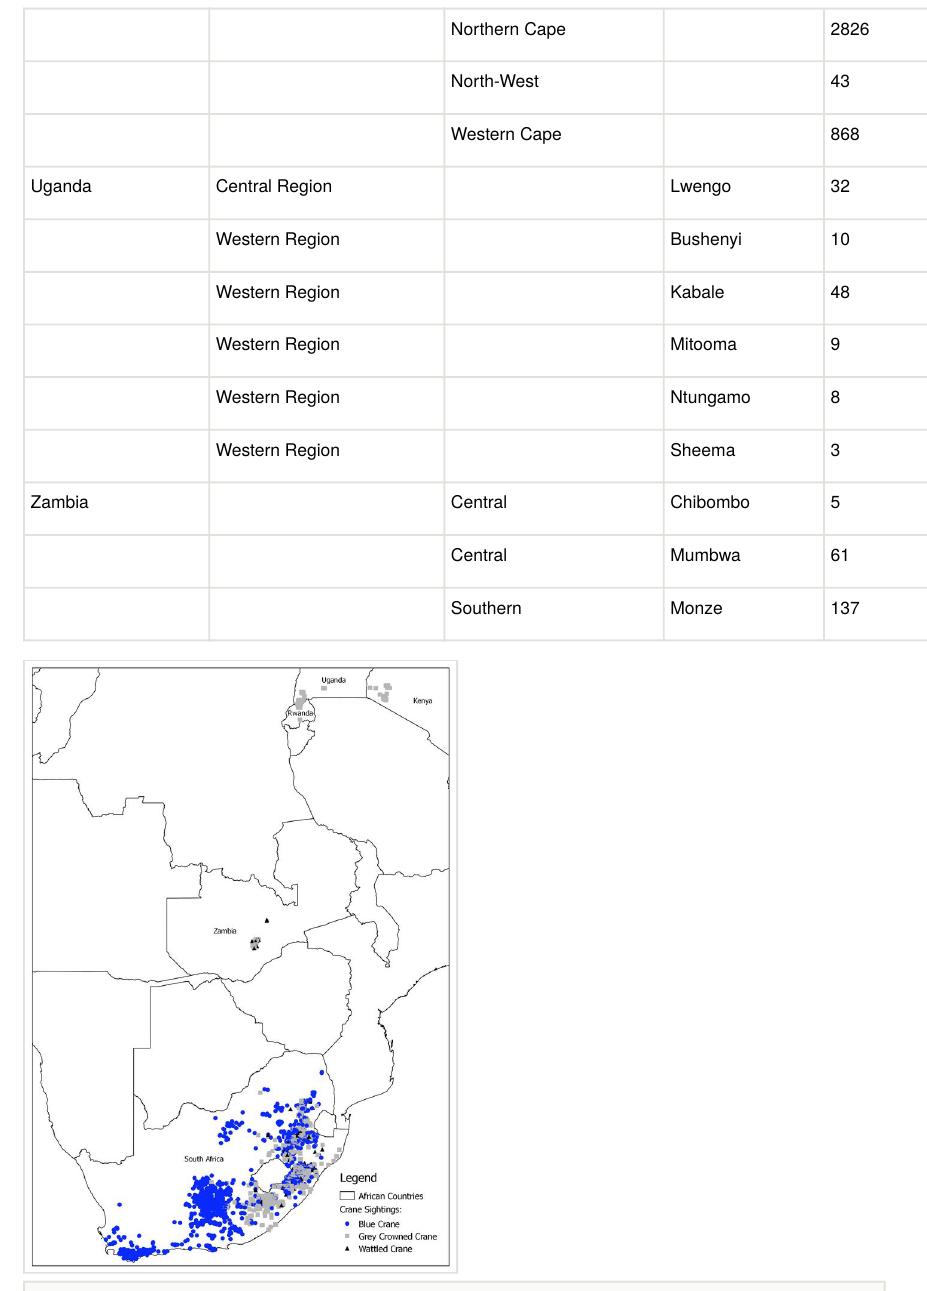
Figure 1. Distribution of crane sightings (1978-2014) of three crane species in